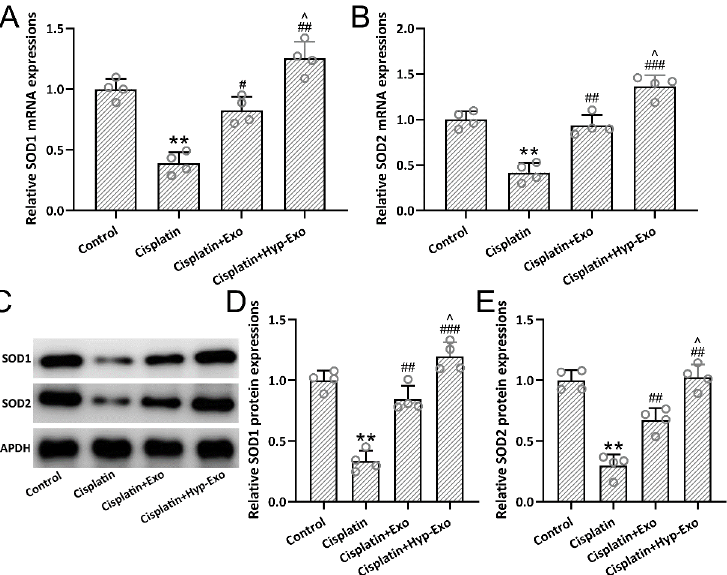
Figure 6. HypBMSC-Exo activated SOD antioxidant signal in cisplatin-exposed mice. The relative mRNA expressions of SOD1 ( A ) and SOD2 ( B ) in the middle turns of the cochlea tissues. The relative protein expressions of SOD1 and SOD2 ( C ) in the middle turns of the cochlea tissues were detected by Western blotting. Quantitative analysis of SOD1 expression ( D ) and SOD2 expression ( E ). The data are shown with mean ± SD. The experiments were repeated 4 times with homogenate from 8 mice in each group. ** p < 0.01 compared to control, # p < 0.05, ## p < 0.01, ### p < 0.001 compared to Cisplatin, ˆ p < 0.05 compared to Cisplatin + Exo. One-way ANOVA followed by Tukey’s multiple comparisons test. BMSCs, bone marrow mesenchymal stem cells; SD, standard deviation; SOD, superoxide